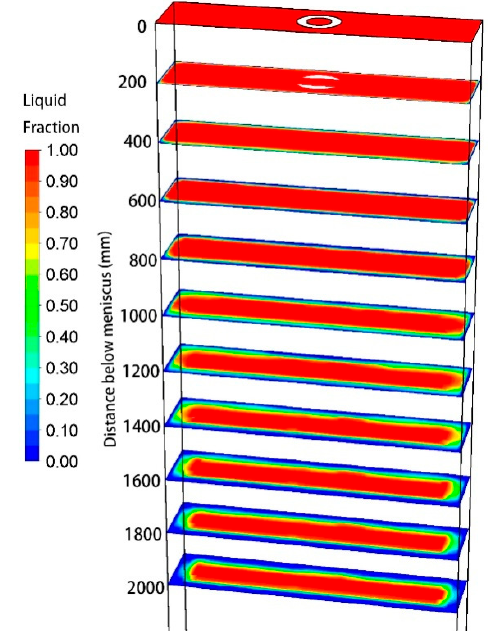
Figure 11. The contour of the liquid fraction in the different Z planes.